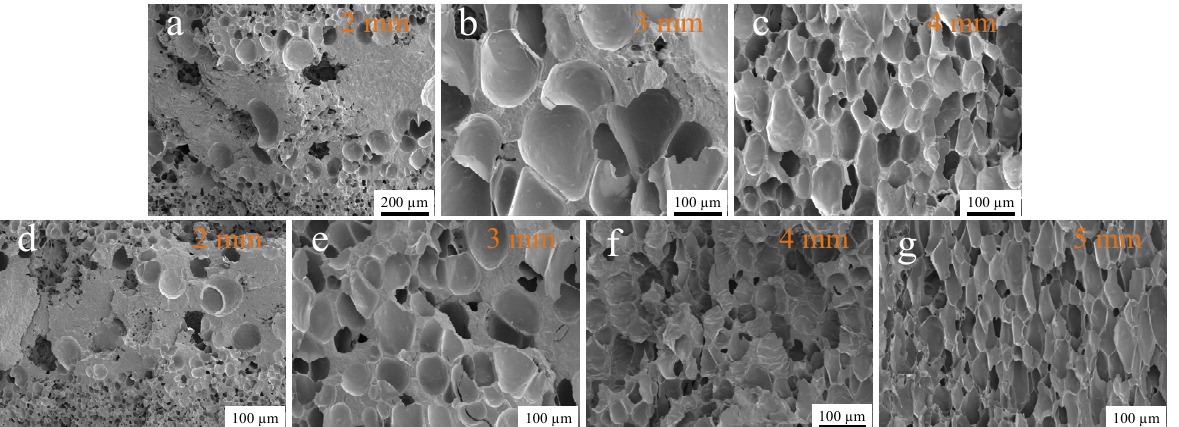
Figure 9. cell morphology of PP/GN nanocomposite microporous plastic parts prepared by MOFIM technique, PP/0.05%GN nanocomposite foams with opening distance of ( a ) 2 mm, ( b ) 3 mm, ( c ) 4 mm, PP/0.1%GN nanocomposite foams with opening distance of (d) 2 mm, ( e ) 3 mm, (f) 4 mm, ( g ) 5